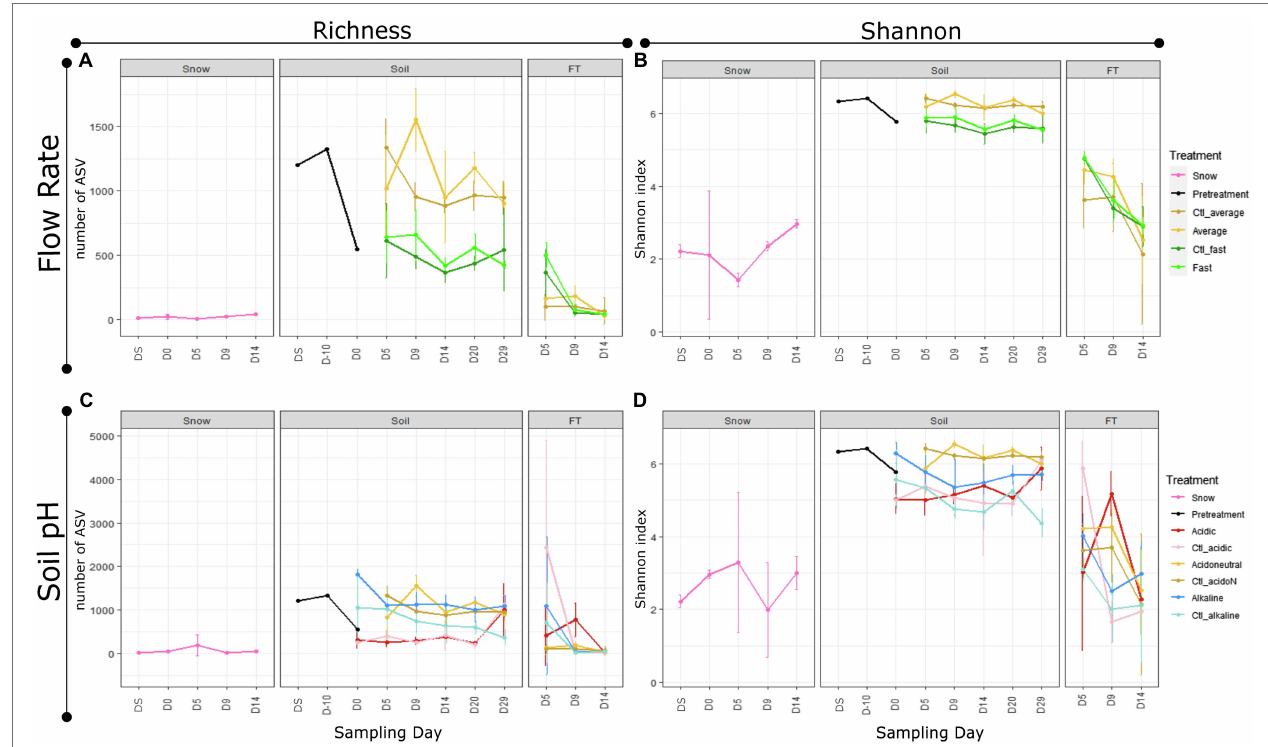
FIGURE 2 | Alpha diversity by experiment, treatment, sample type and day of sampling. (A) Observed number of amplicon sequence variants (ASVs) (Richness) and (B) diversity with the Shannon index in different flow rate experiments. (C) Observed number of ASVs (Richness) and (D) diversity with the Shannon index in different soil pH experiments. The shades of yellow correspond to the average and acidoneutral controls (Ctl) and treatments, resulting from the same